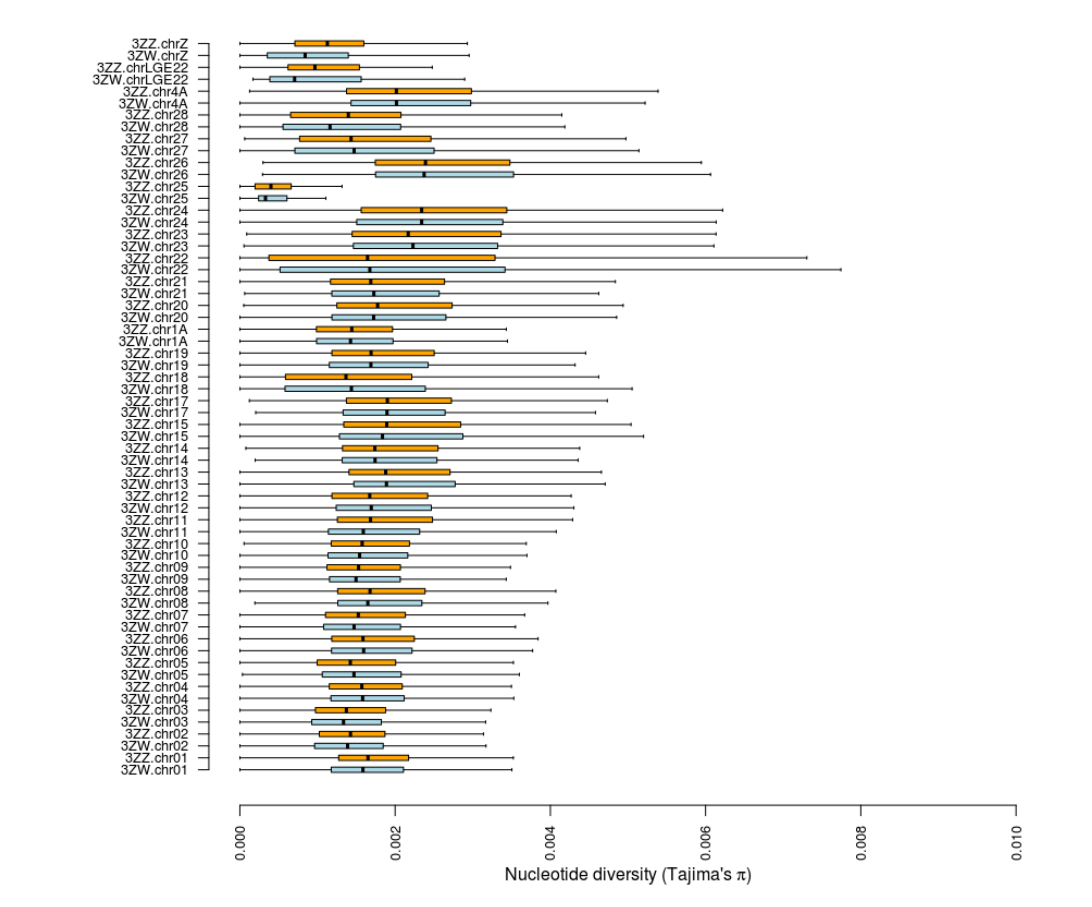
Figure S4. Inter chromosomal and interdataset variation in Tajima’s π females (light blue) and π males (orange) over non-overlapping 10-kb sliding